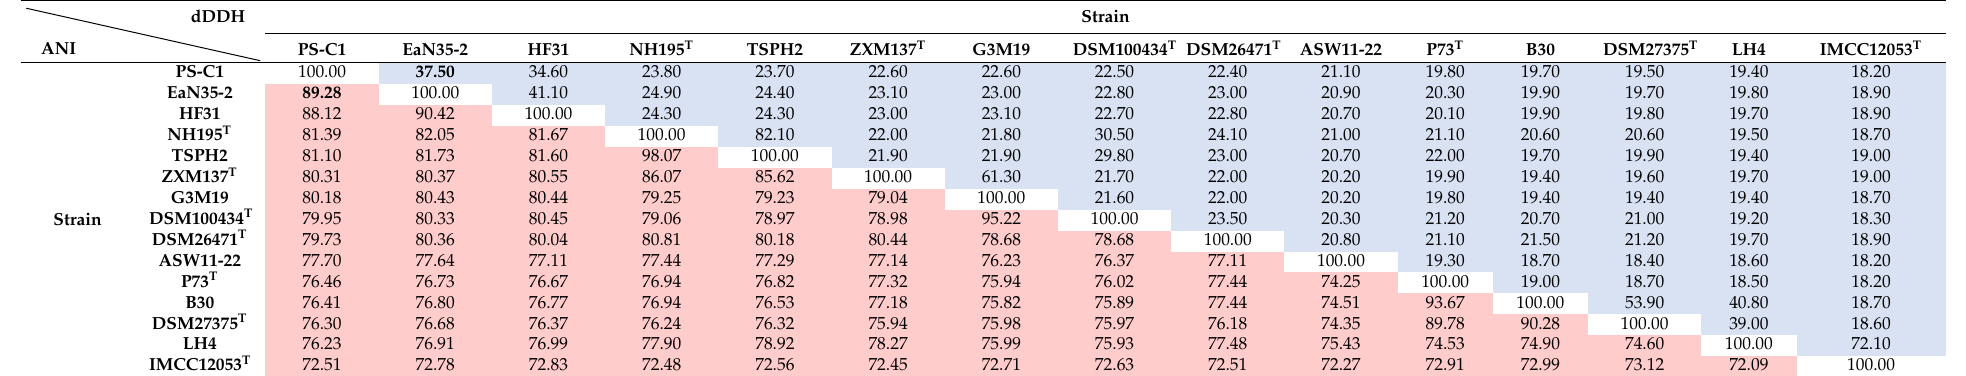
Table 3. Genomic comparison of strain PS-C1 against all available genomes of Celeribacter spp. using Genome-to-Genome Distance Calculator (GGDC) and Average Nucleotide Identity